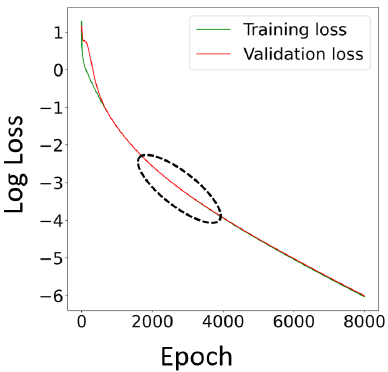
Figure 11. Decision on stopping criteria: the percentage difference between the validation loss and the training loss is minimal in the marked region.